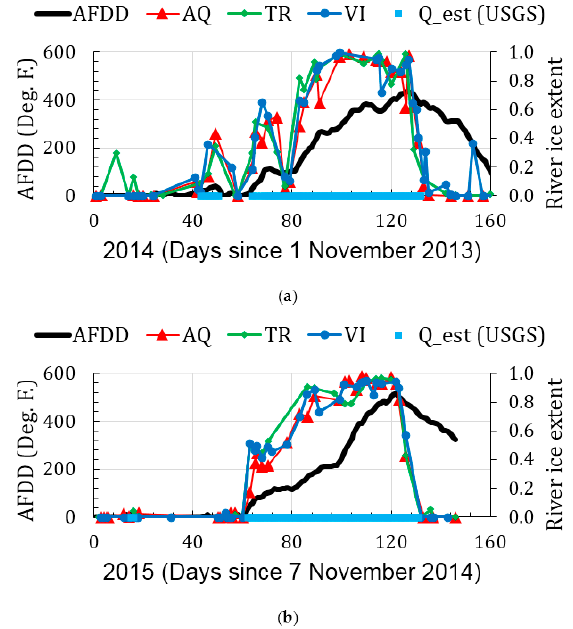
Figure 5. Time series of river ice extent (% river grid classified as ice) obtained from STC processing of MODIS and VIIRS reflectance data are shown for: 2014 ( a ); and 2015 ( b ). Markers indicate dates for which data were processed by STC. For reference, the result of the discharge quality flag at the hydrometric station is plotted, where Q_est is taken as ice detection. For contextual reference a plot of the accumulated freezing degree-day curve (AFDD) is provided: its increase (decrease) signifies below (above) freezing temperatures.